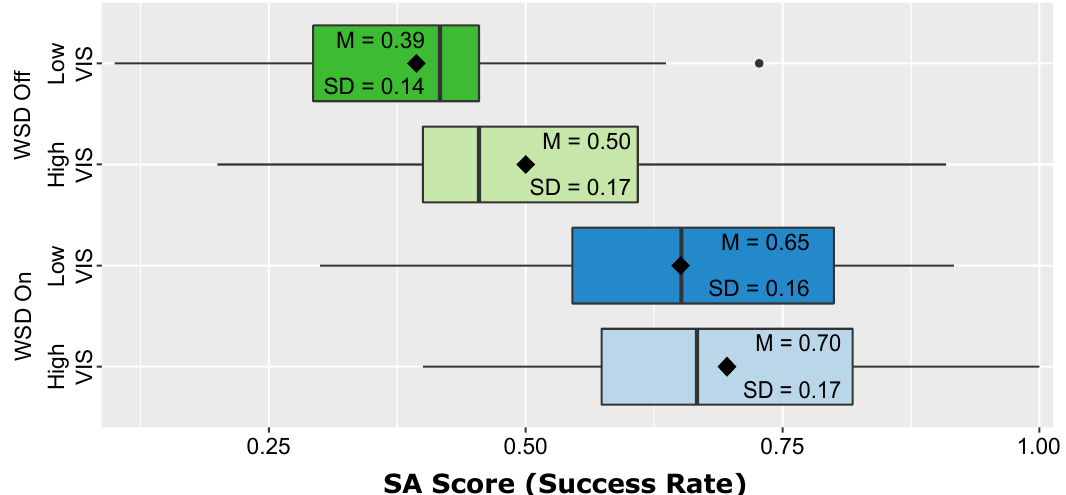
Figure 8. Results for the objective SA scores collected with the SAGAT-like freeze probes. Score numbers correspond to success rates regarding the SA test questions. Table 3. Results of the Wilcoxon–Pratt signed-rank tests for SA scores, grouped by visibility conditions (VIS) and windshield display conditions (WSD). Effect size (ES) is given as Hedges’ g with bias correction (g ∗ ) and interpreted with Cohen’s thresholds (0.2, 0.5, 0.8) [52]. VIS High Low